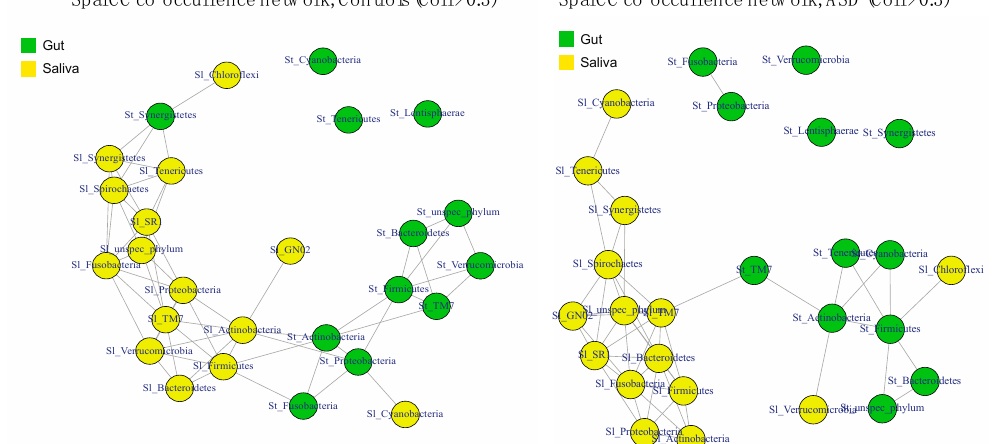
Figure 5. ( A ) Phylum-level heat map expression profiles of gut and oral microbiomes in ASD patients. ( B ) PCA of bacterial beta diversity based on Bray–Curtis dissimilarity for saliva and gut (all subjects are represented). Saliva and gut microbiome are colored in yellow and green, respectively. ( C – E ) Gut and oral microbiome phylum level co-occurrence network using the Sparse Correlations for Compositional data (SparCC) method with a correlation cut-o ff > 0.3 (( C ) all subjects, ( D ) control only, ( E ) ASD only). Each node represents a saliva (Sl) or stool (St) phylum, and saliva and stool microbiomes are colored in yellow and green, respectively. The dotted red circle highlights a co-occurrence cluster with the greatest inter-nodal correlations.